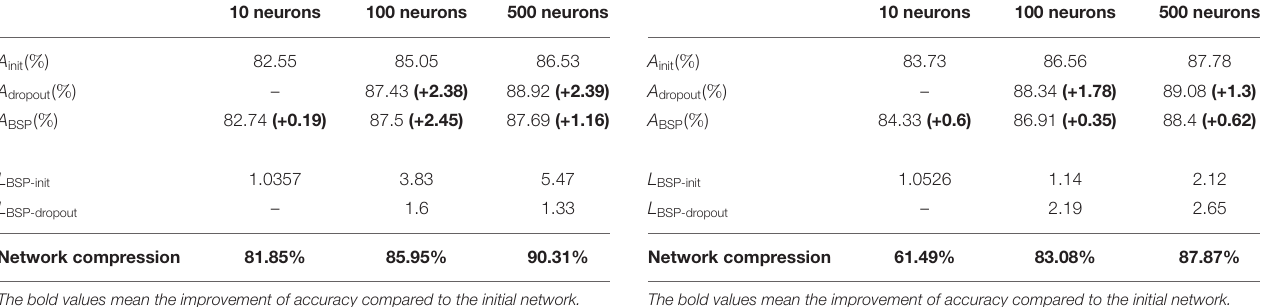
10 neurons 100 neurons